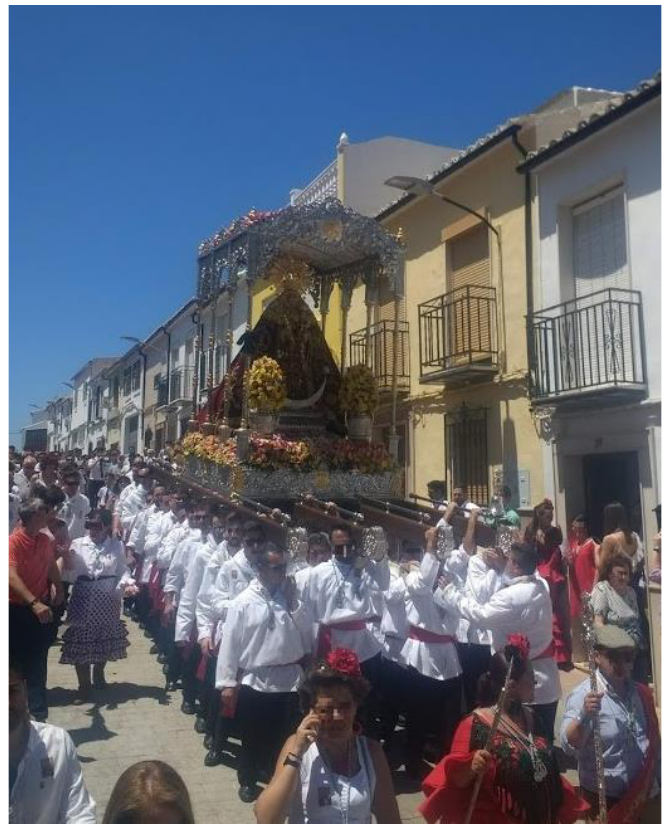
Photograph 1: Residents carry a Virgin Mary statue in a fiesta procession (N.B. faces blurred to protect anonymity). Photograph taken by author. May,